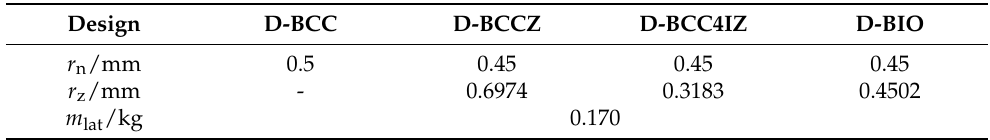
Table 2. The parameters of four